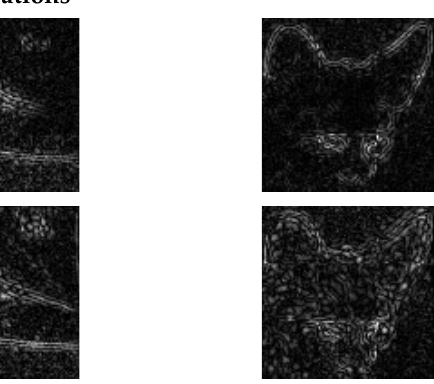
Figure 4. Comparisons of perturbation generated by D_Rec networks.